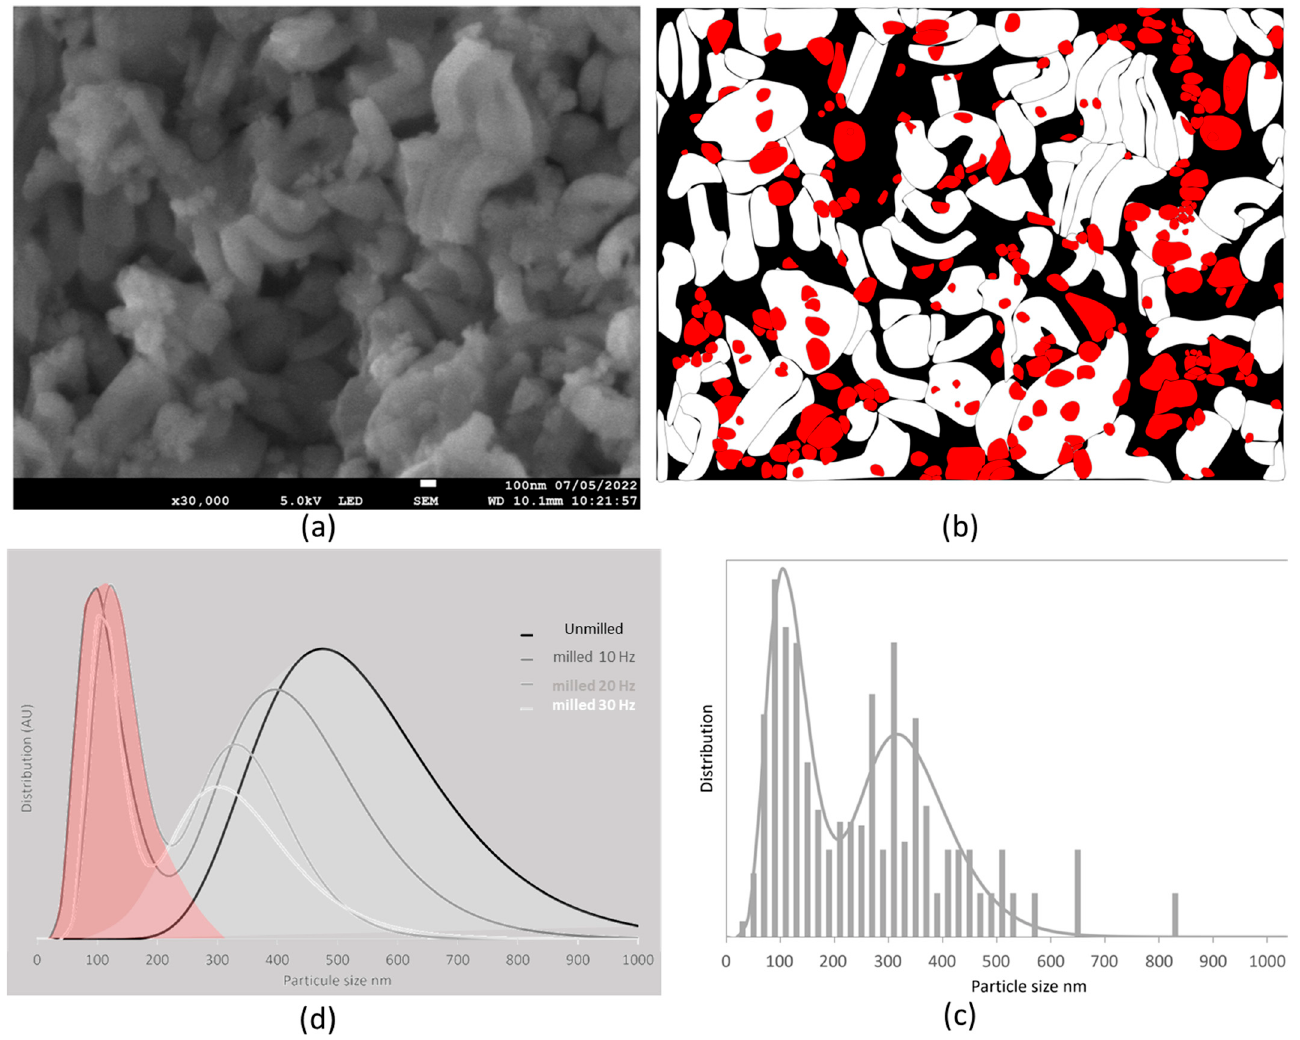
Figure 9. Distribution of particle sizes: ( a ) example of a raw SEM micrography of an SBA-15 specimen milled at 10 Hz; ( b ) corresponding particles traced with hand (small particles are colored in red and big particles are colored in white); ( c ) bimodal distribution of particle sizes of an SBA-15 specimen milled at 20 Hz; ( d ) evolution of the distribution of particle sizes with the milling frequency. Table 2. Evolution of particle and proportion size with milling